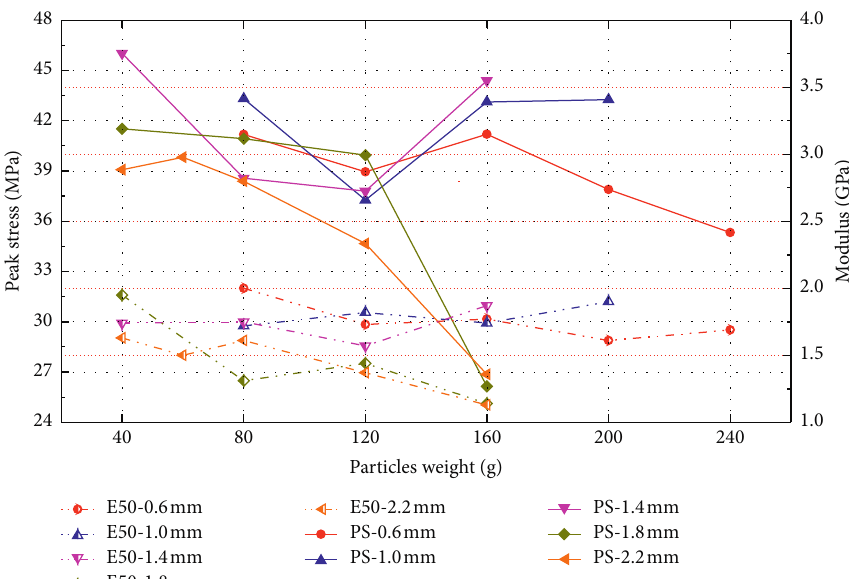
Figure 5: Relationships between the particle weight and peak stress/E50 under various particle